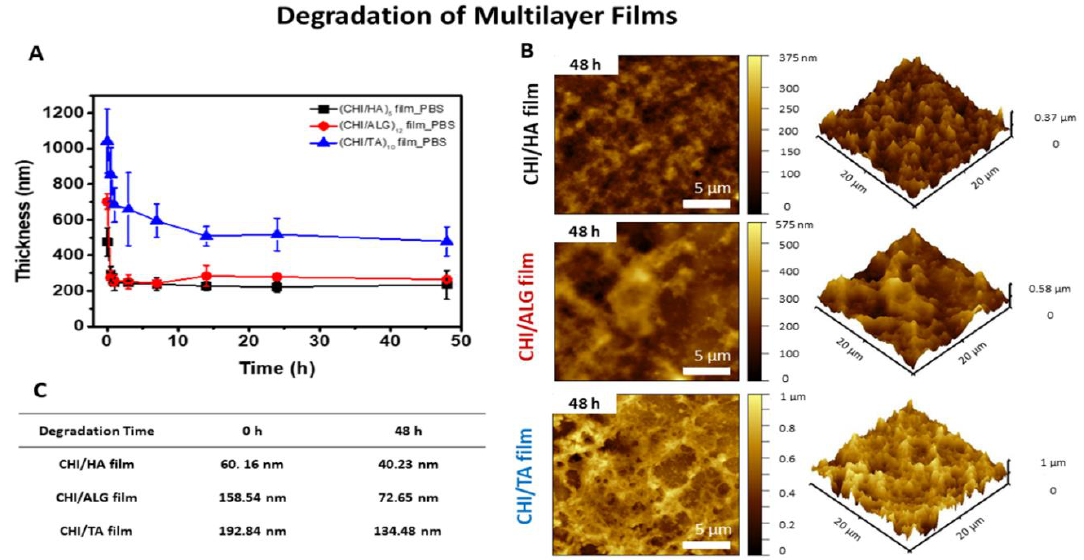
Figure 4. ( A ) Degradation rate of multilayer films under 1× PBS at 37 °C measured by changes in thickness. ( B ) Surface morphology of multilayer films under 1× PBS at 37 °C for 48 h. ( C ) Surface roughness of multilayer films measured by AFM.